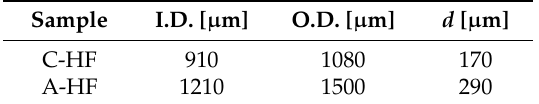
Figure 8. SEM cross-sectional image of the A-HF membrane. ( a ) Overall membrane image and ( b ) close up image of the cross-section. Table 2. The diameters and thickness of the prepared hollow fiber type